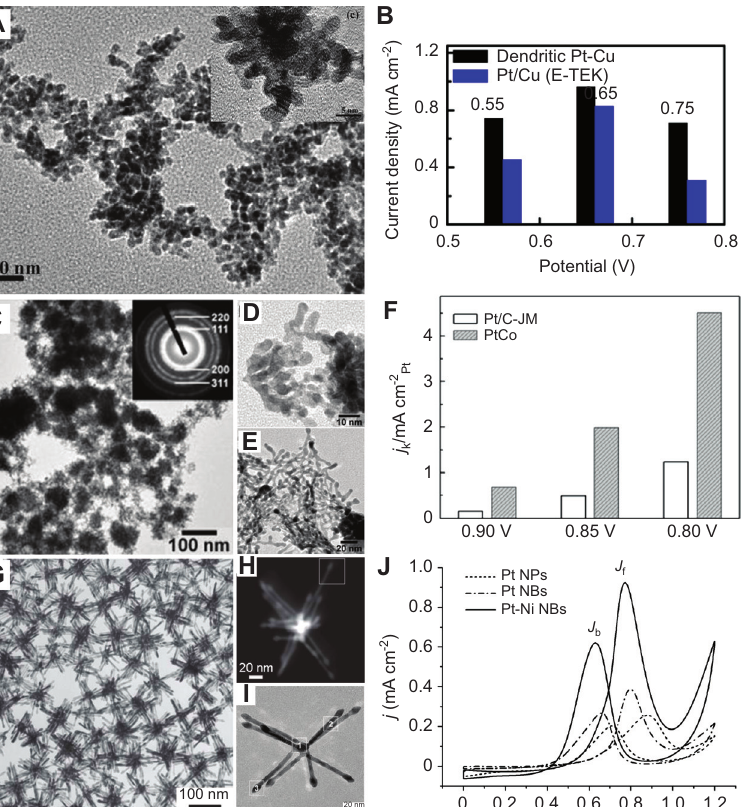
(Figure 6E) [47]. The resultant Au-Pd dendritic nanostruc- tures exhibited better electrocatalytic activity and stability for ethanol oxidation relative to Au-Pd alloy nanoparticles. Very recently, hexadecylpyridinium chloride has been used as a soft template to grow Au-Pd porous nanostructures. This structure exhibited a distinct morphology compared to the other reported dendrites – the pore channels of the Pd shell are perpendicular to the Au core (Figure 6F)